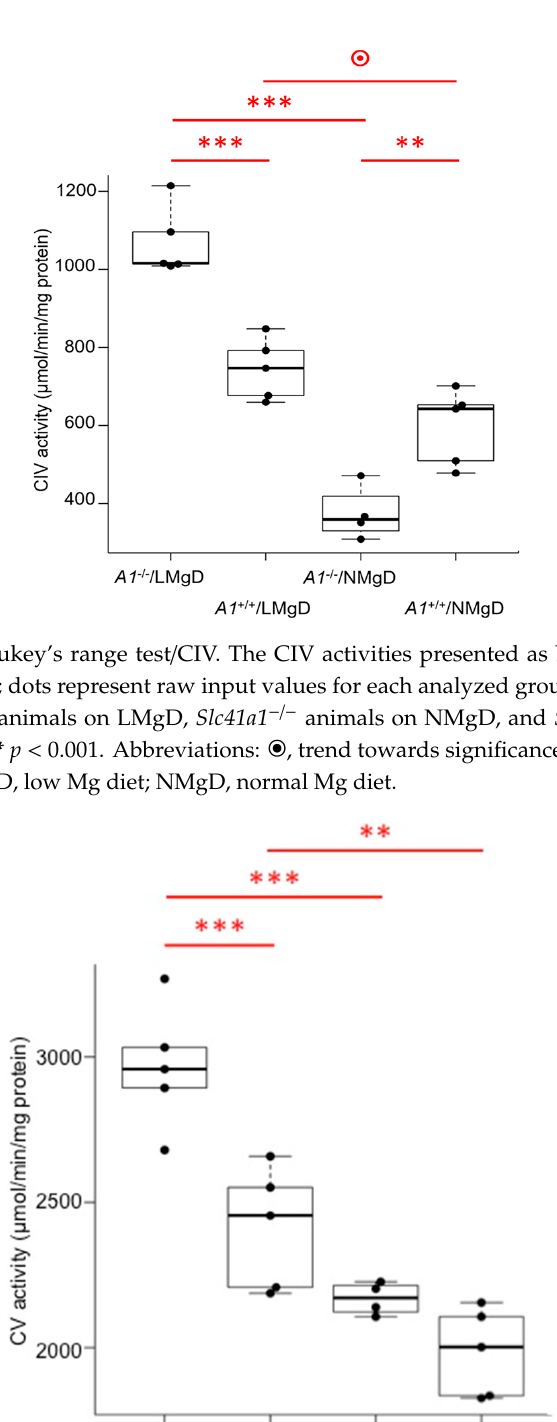
Figure A3. Post-hoc Tukey’s range test/ACON. The ACON activities presented as box-and-whisker plot overlaid with dot plot; dots represent raw input values for each analyzed group ( Slc41a1 − / − animals on LMgD, Slc41a1 +/+ animals on LMgD, Slc41a1 − / − animals on NMgD, and Slc41a1 +/+ animals on NMgD); * p < 0.05. Abbreviations: ⦿ , trend towards significance ( p < 0.1); A1 , ACON, aconitate hydratase; Slc41a1 ; LMgD, low Mg diet; NMgD, normal Mg diet.